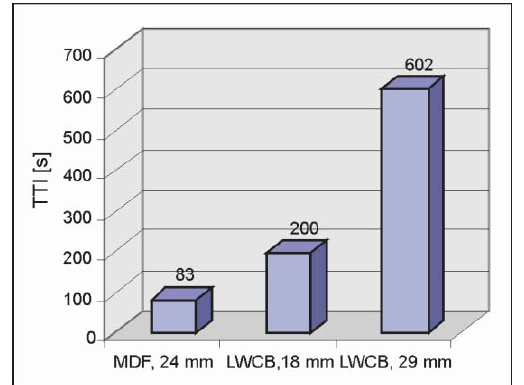
Fig. 4. Mean time to ignition (TTI) when exposed to the surface heat flow density of 70 kW/m 2 for different tested boards